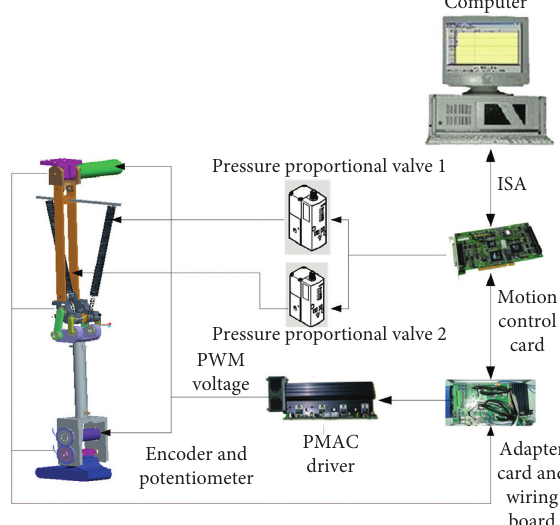
Figure 4: The control system of the artificial leg.